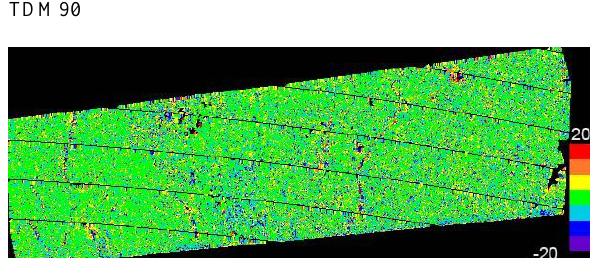
Figure 17. CORONA DSM corrected by ZFIT based on TDM90